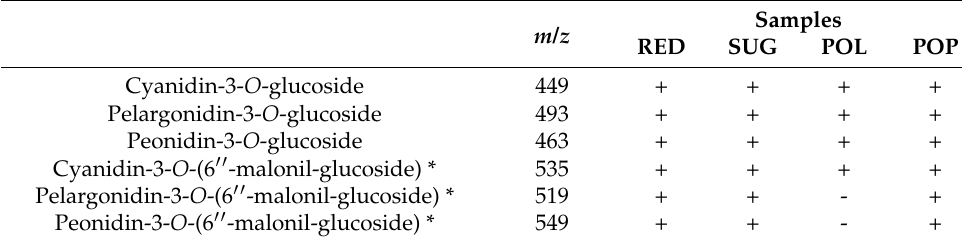
Table 2. Anthocyanins identified in pigmented samples.